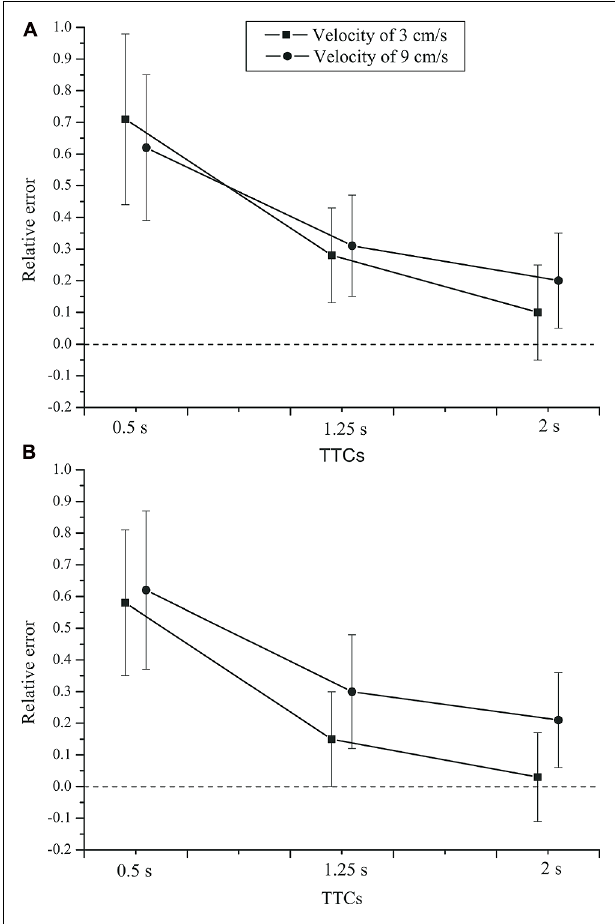
FIGURE 6 | Mean relative error of theTTC estimates as a function of TTC, velocity, and group. (A) Control group. (B) Depressive patients. Error bars: 95% CIs.